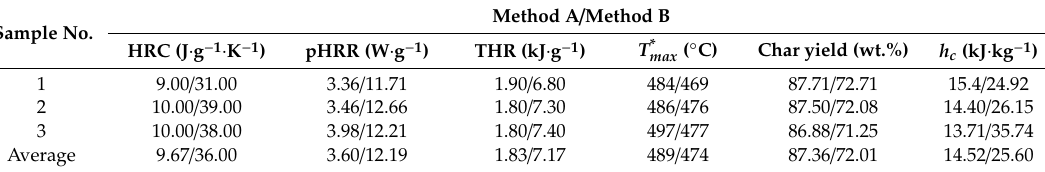
Table 4. PCFC parameters for the OSM layer.